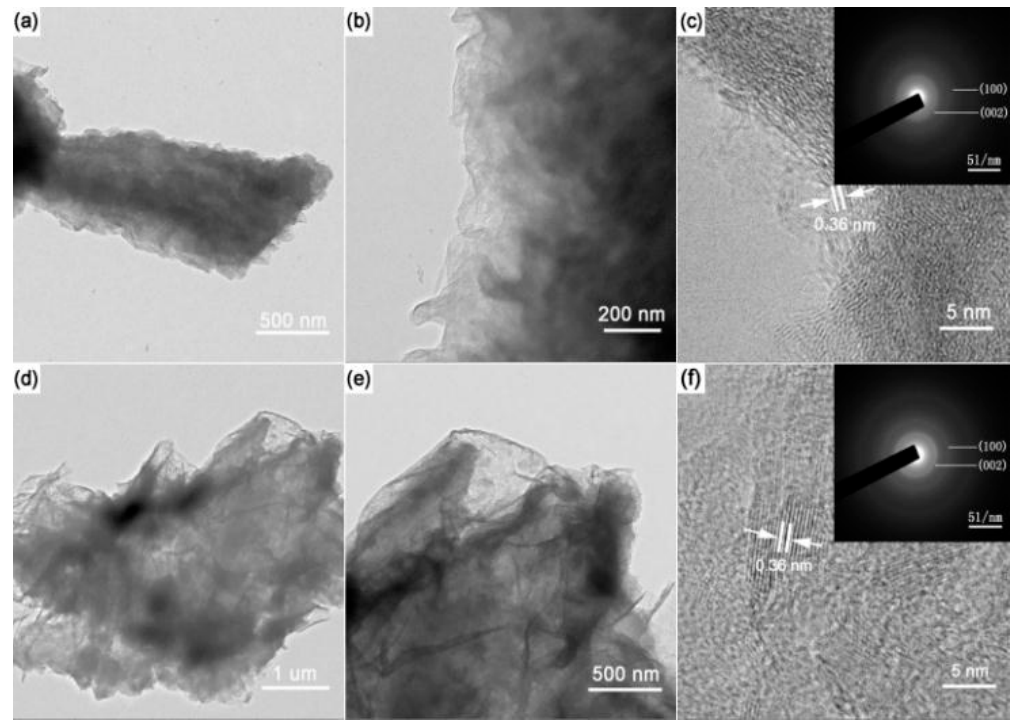
Figure 4. ( a – c ) TEM images and the corresponding HRTEM images of BCN-800; ( d – f ) TEM images and the corresponding HRTEM images of BCN-900.